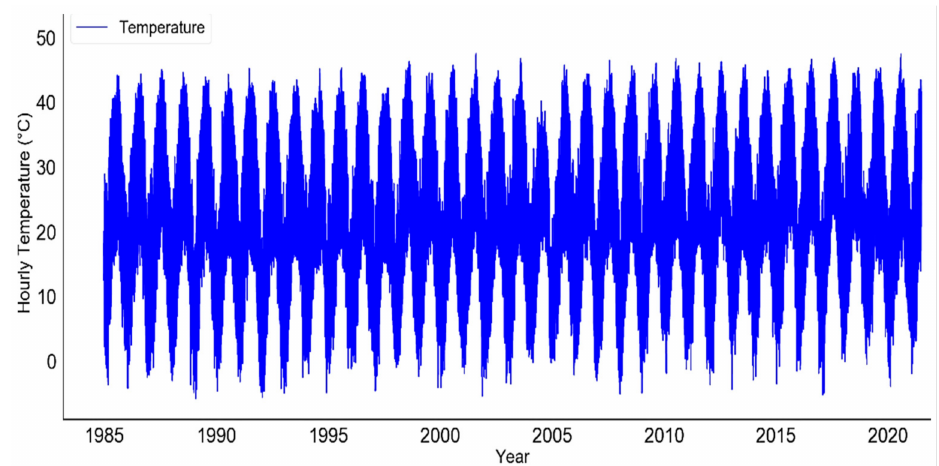
Figure 15. Hourly intervals historical performance of the